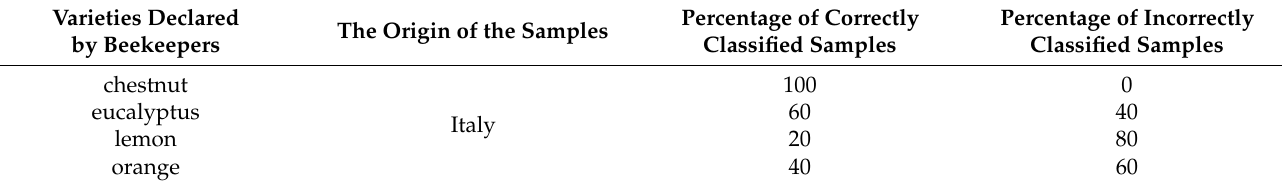
Table 2. Results of the melissopalinological